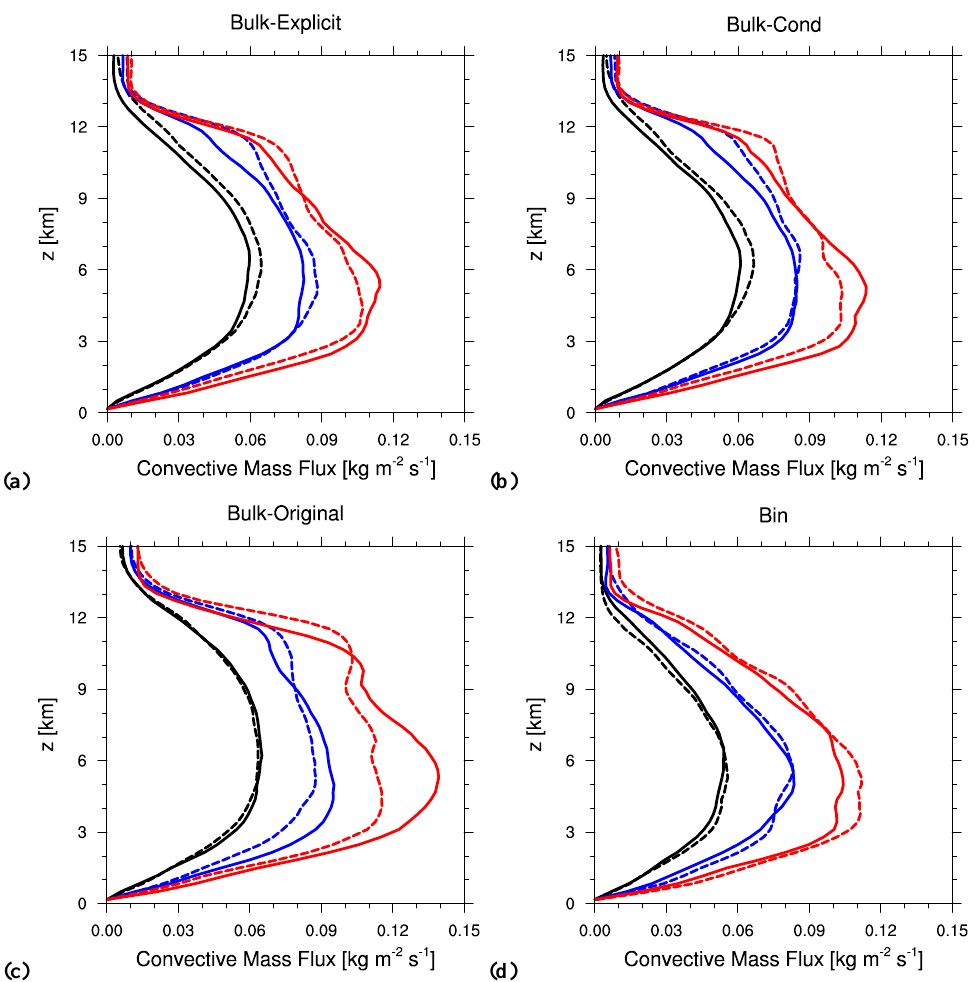
Fig. 8. Domain-average convective mass flux profiles for all four model configurations at 60min (black), 90min (blue), and 120min (red). Depicted here are the “Clean” (solid) and “Polluted” (dashed) aerosol scenarios for the baseline initial